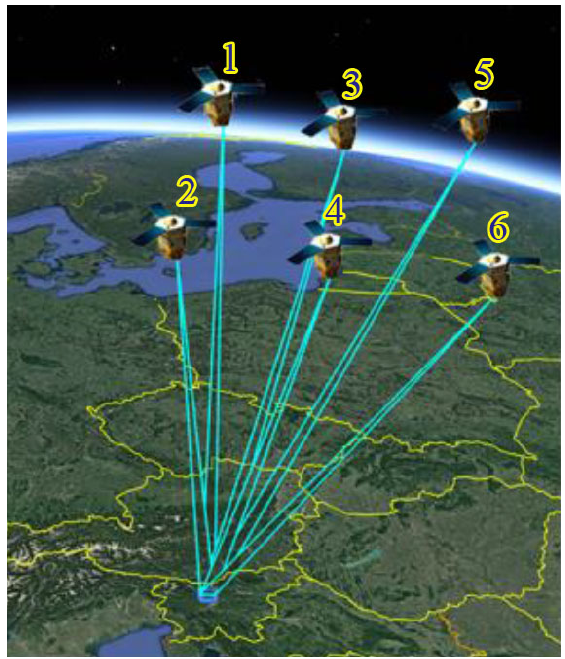
Figure 6. Multiple view geometry Ljubljana data set, adapted from Reference [5]. The Google Earth visualization depicts the preview of the footprints and the satellite’s position.